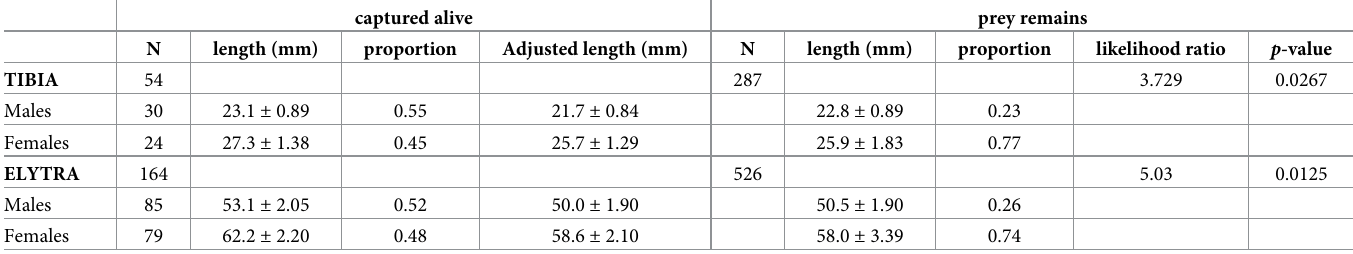
Table 5. Mean length (mm) ± s.d. of tibiae and elytra of male and female desert locusts captured alive and in prey remains. For length adjustments because of drying of prey remains, see text. The bimodal distribution of prey remains over the sexes has been separated by applying the likelihood ratio test [34].